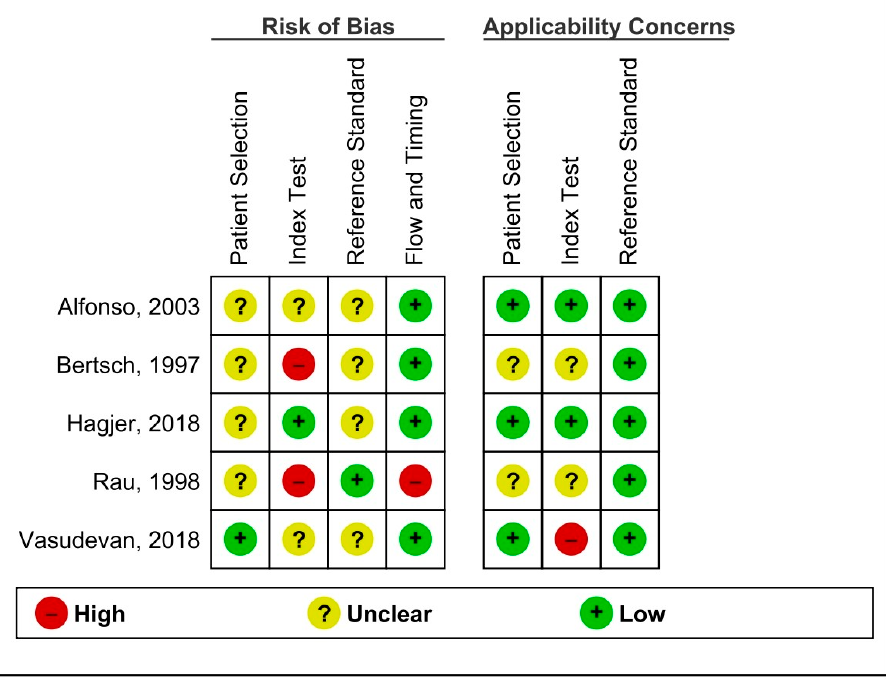
Figure 6. Risk of bias and applicability concerns.